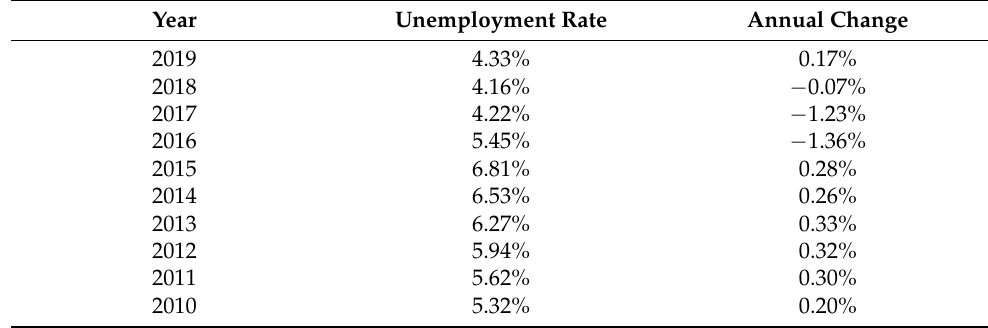
Table 7. Unemployment rate and annual change in Ghana